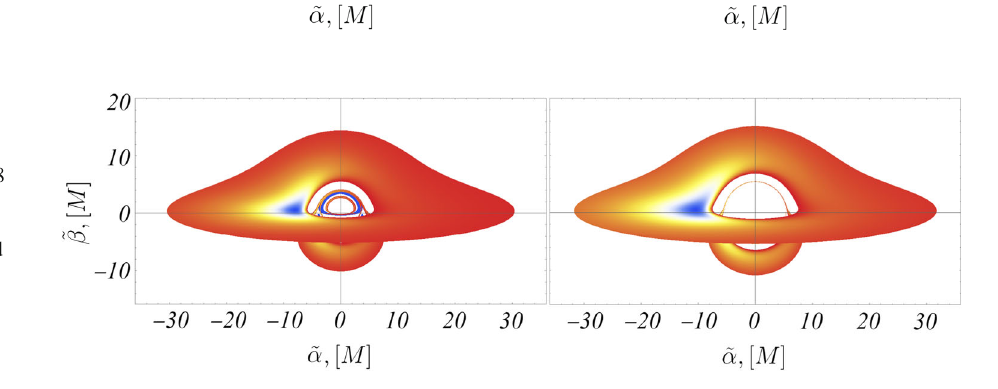
Fig. 22 Curves of constant observable flux (left) and its continuous distribution (right) for the inner disk of the strongly naked singularity with γ = 0 .